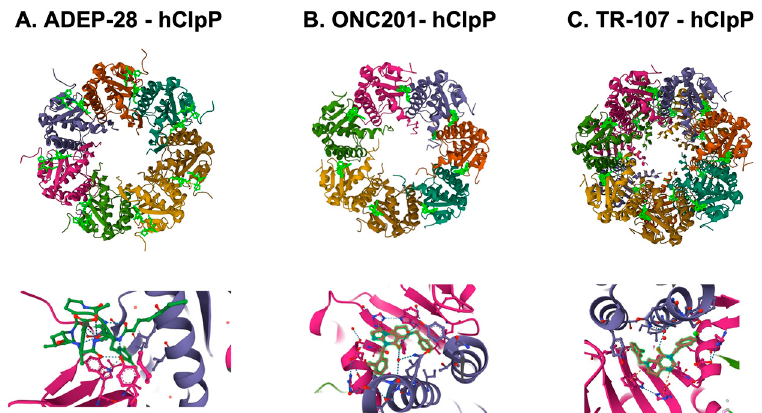
Figure 7. Crystal structures of human mitochondrial ClpP complex with ClpP ligands. ( A ) ADEP- 28-hClpP binding [283] (PDB DOI:10.2210/pdb6BBA/pdb), ( B ) ONC201-hClpP [271] (PDB DOI: 10.2210/pdb6DL7/pdb), ( C ) TR-107-hClpP [294]. (PDB DOI: 10.2210/pdb7UVU/pdb). Top panels show that each ClpP ligand (bright green) bound to ClpP. One heptamer ring for ADEP-28 and ONC201, or two heptamer rings for TR-107 are shown. Each subunit of ClpP is shown in a different color. Bottom panels show a magnified view of ligands (bright green) bound to the pocket between two ClpP subunits.